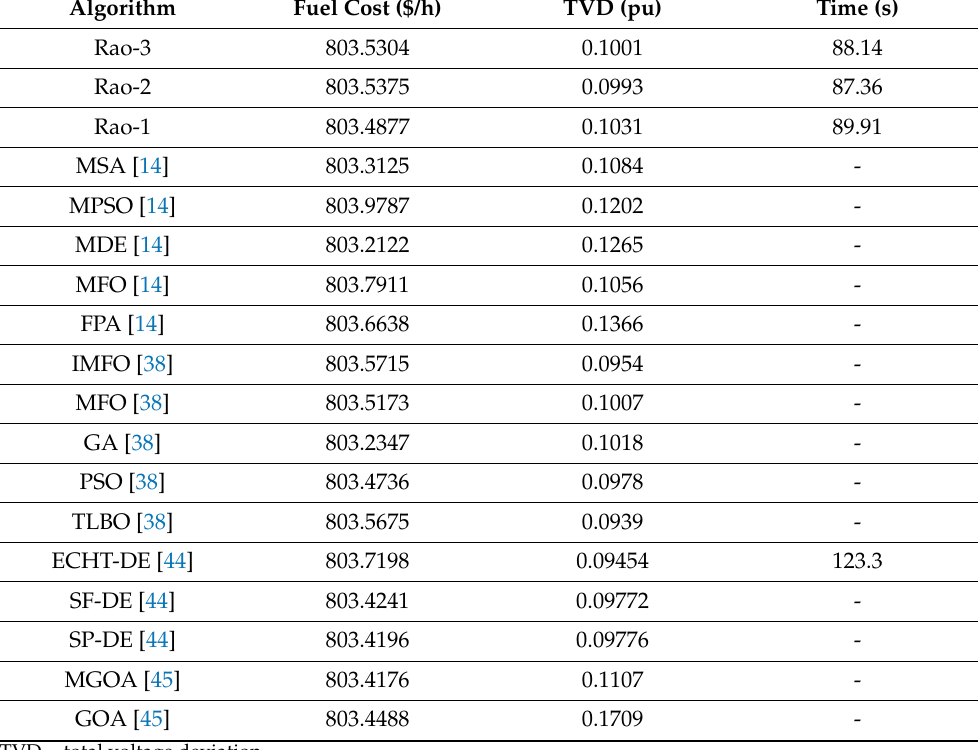
Table 4. Case 2: VPI in the IEEE 30-bus system.